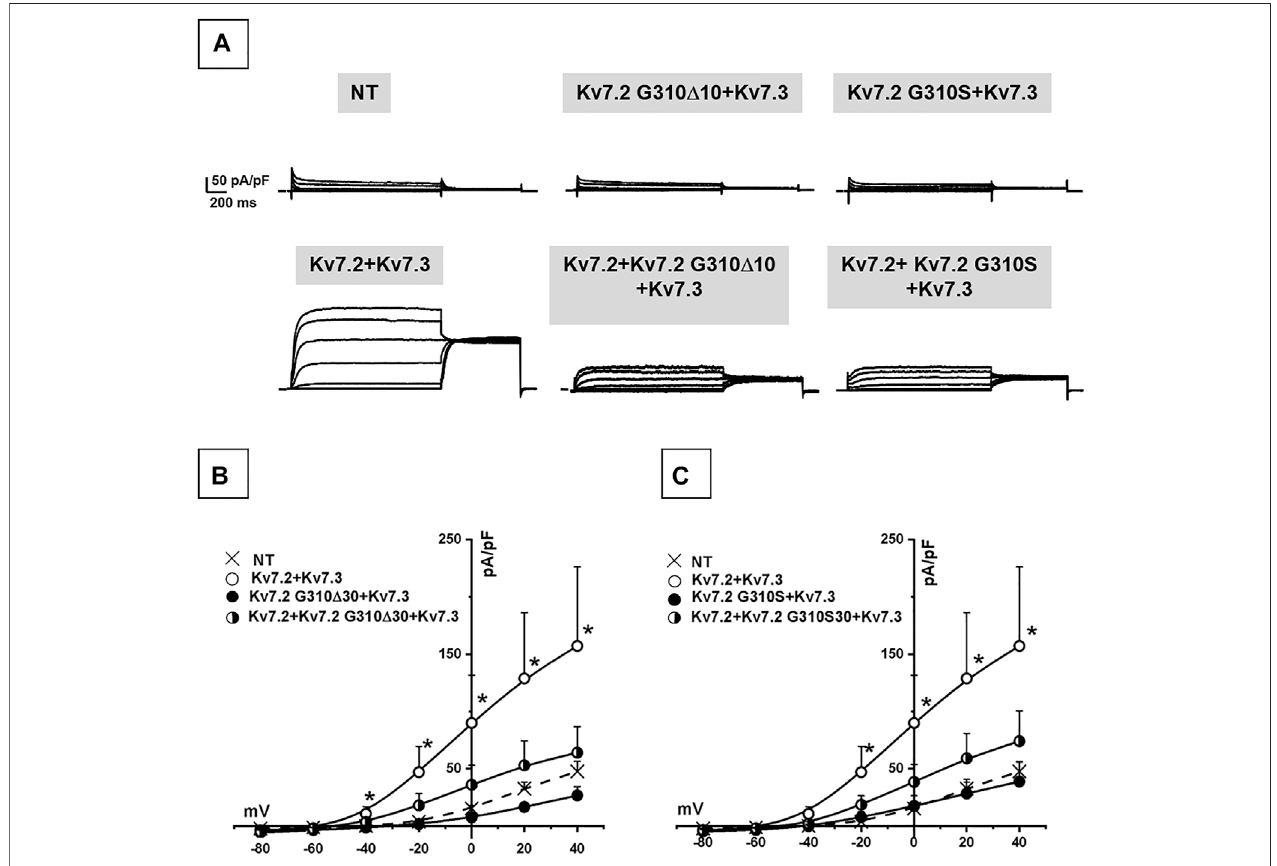
FIGURE 3 | Functional characterization of heteromeric Kv7.2 + Kv7.3 channels incorporating Kv7.2 G310S or Kv7.2 G310 Δ 10 subunits expressed in neurons. (A) Macroscopic currents from neurons expressing wild-type or mutant Kv7.2 + Kv7.3 subunits, as indicated. (B,C) Current density/voltage curves measured in non transfected neurons (NT) or expressing the indicated channels incorporating Kv7.2 G310 Δ 10 (B) or Kv7.2 G310S (C) subunits, as